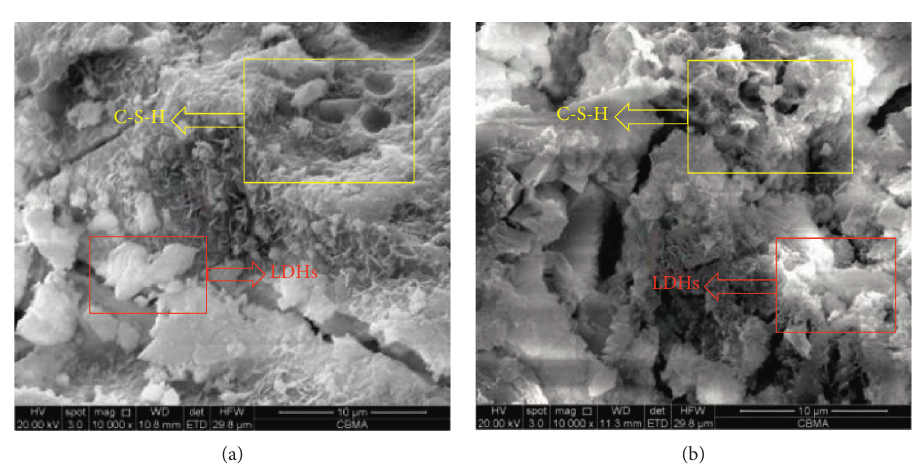
Figure 16: SEM image of concrete carbonation zone. (a) NL-2. (b) CL-2.